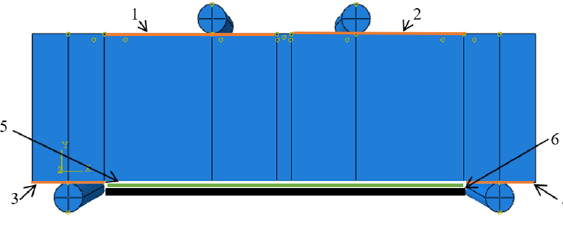
Fig. 5. Contact surface interactions in modelling.